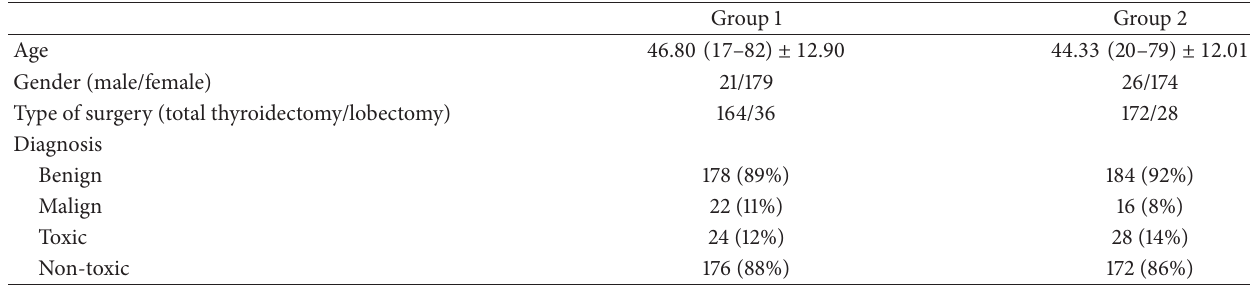
Table 1: Patient characteristics.